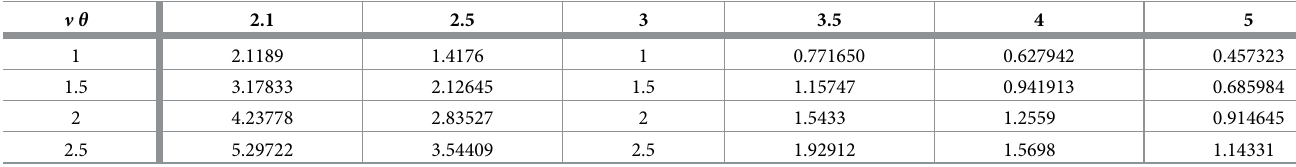
Table 11. Optimal value of M in the Pareto